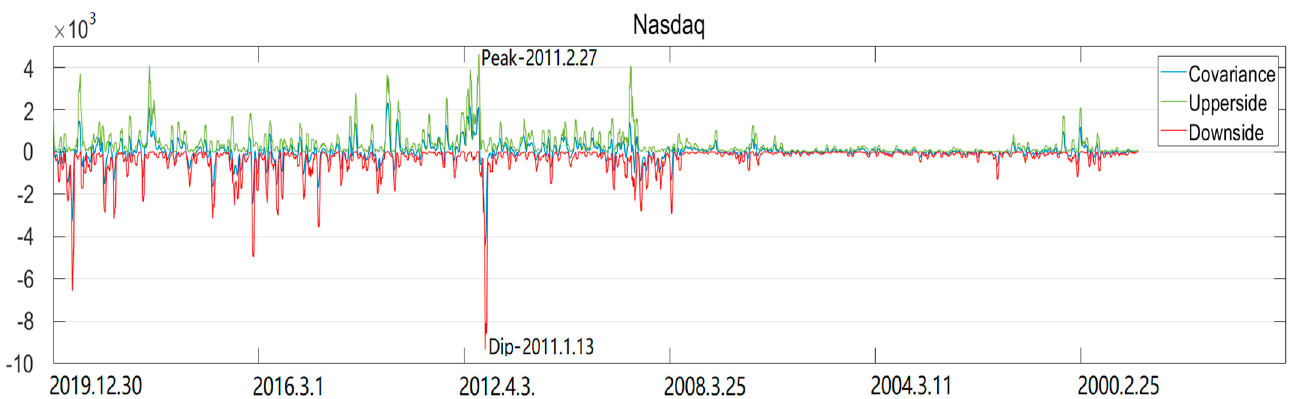
Figure 3. Bi ‐ weekly/semi ‐ covariances between gold price and N asdaq Index USA from the year 2019 back to 1999.